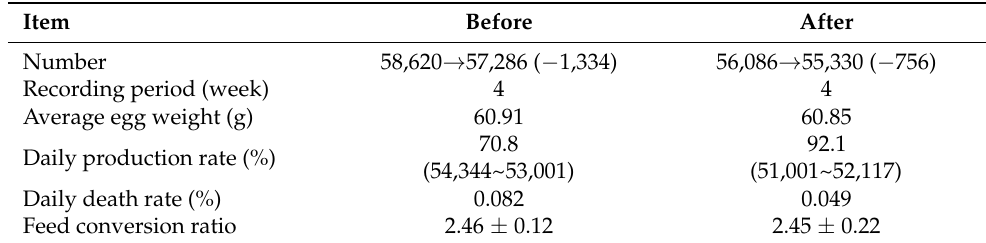
Table 2. ALPS in water-pad layer house, Dalin, Chiayi.